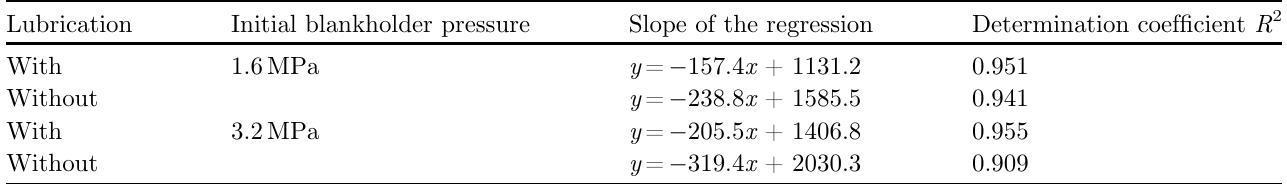
Table 10. Regression analysis of variation of the drawing radius in the case of using MMC tool without depression.